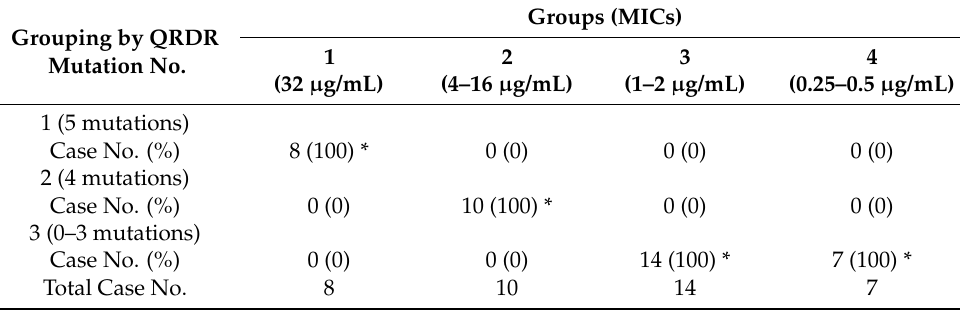
Table 4. Cross tabulation of QRDR mutation numbers and MIC groups. Grouping by